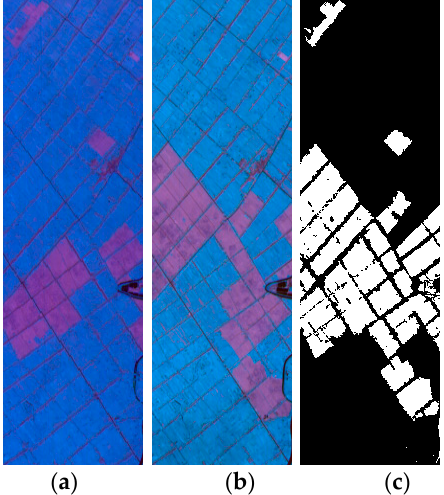
Figure 5. Real-world bitemporal data, including false color composition by bands 20, 40 and 60 of: ( a ) images acquired on 3 May 2006; ( b ) images acquired on 23 April 2007; and ( c ) ground truth map with changed areas in white and unchanged areas (background) in black.